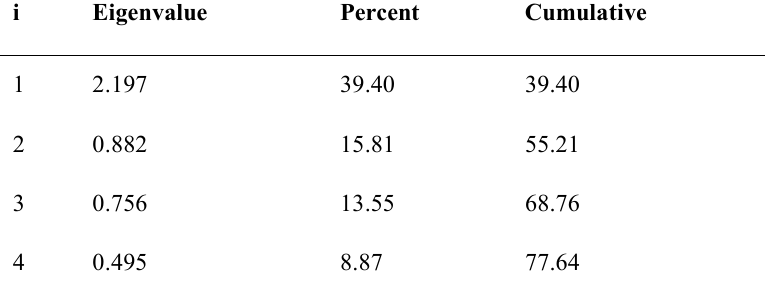
Table 3. Cumulated percent of variation in axes 1-4 in PCO analysis.